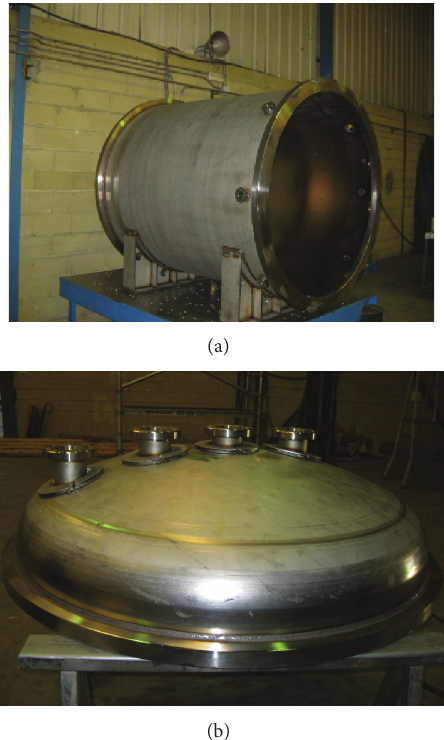
Figure 12: The pressure-resistant enclosure or “can” protecting the PMTs inside the pressure